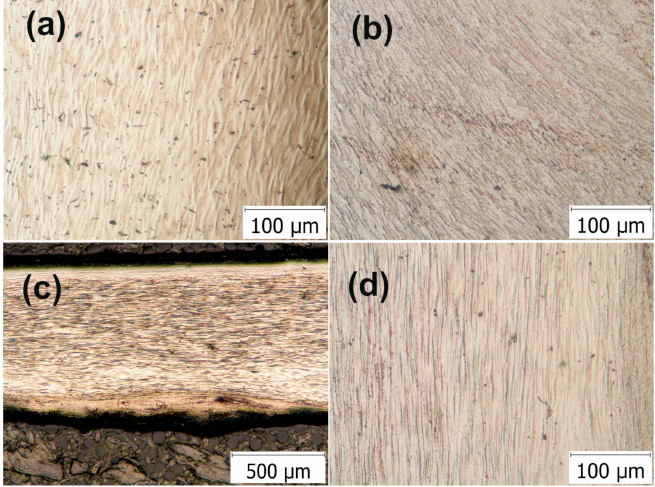
Figure 2. Optical microscopy images showing the microstructure of the Ti-Nb-Zr-Ta-Fe-O alloy subjected to HSHPT with: 0.68 ( a ), 1.3 ( b ) and 2.02 ( c , d